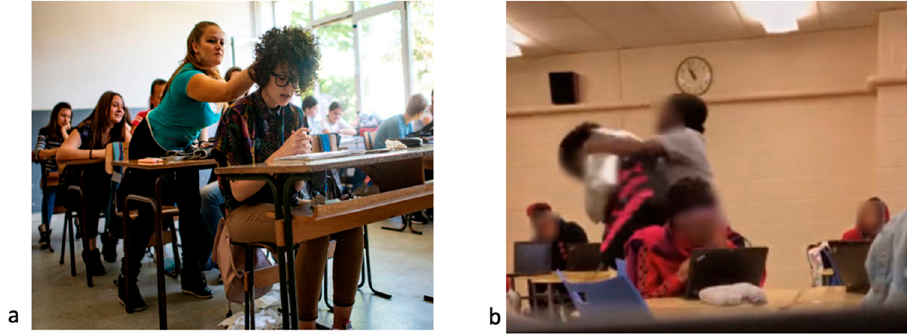
Figure 11. Samples of “violence student bullying” on ( a ) and “violence student fight” on ( b ).